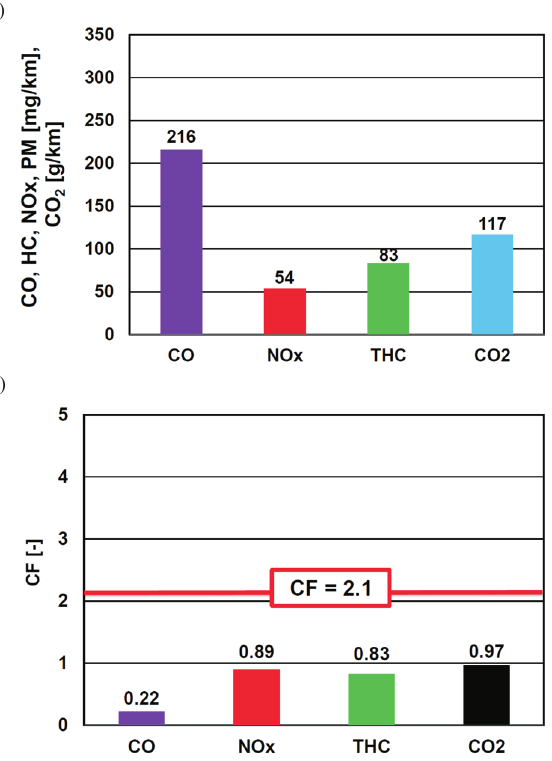
Fig. 5. The nitrogen oxides concentration relative to the engine operating parameters during the RDE test: a) gasoline engine, b) diesel engine